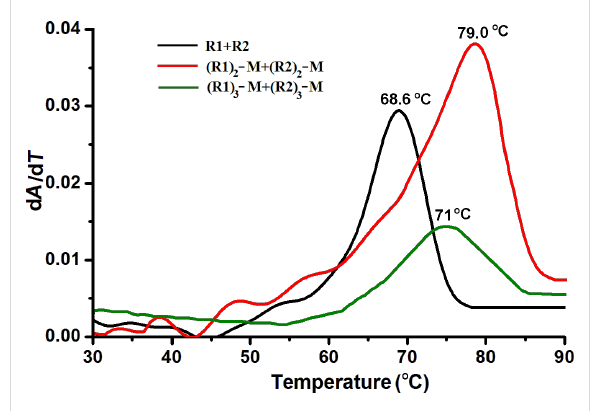
Figure 2: First-order derivatives of UV absorbance melting profiles at 260 nm for a control (R1–R2) and DNA–melamine hybrid self- assembly.